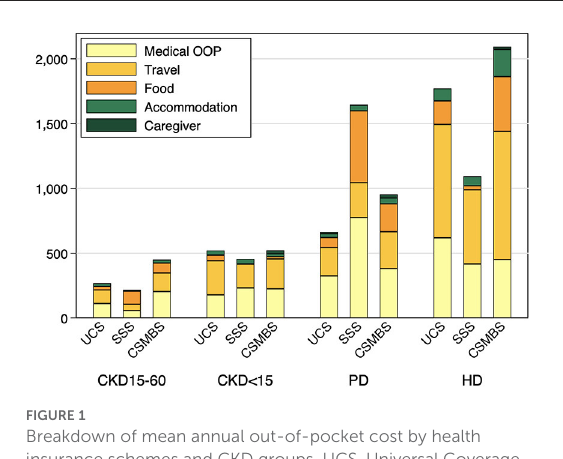
FIGURE1 Breakdown of mean annual out-of-pocket cost by health insurance schemes and CKD groups. UCS, Universal